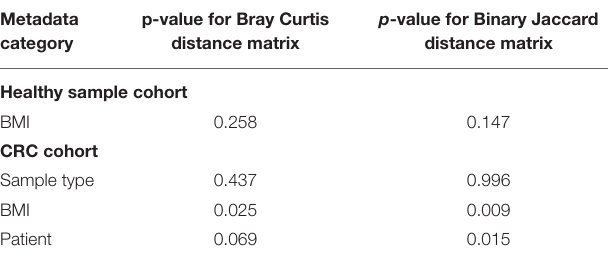
TABLE 4 | PERMANOVA results produced by Adonis of the R package Vegan showing the contribution of each metadata category to the sample distances. Metadata category